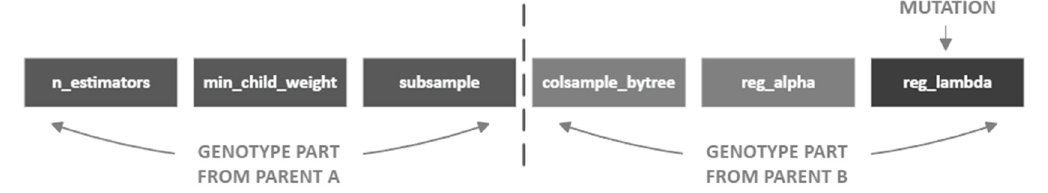
Figure 8. Exemplary hyperparameter child genotype from the evolutionary algorithm.